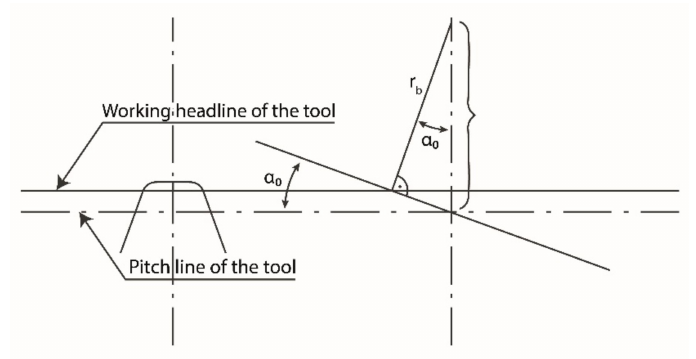
Figure 1. Boundary position of the